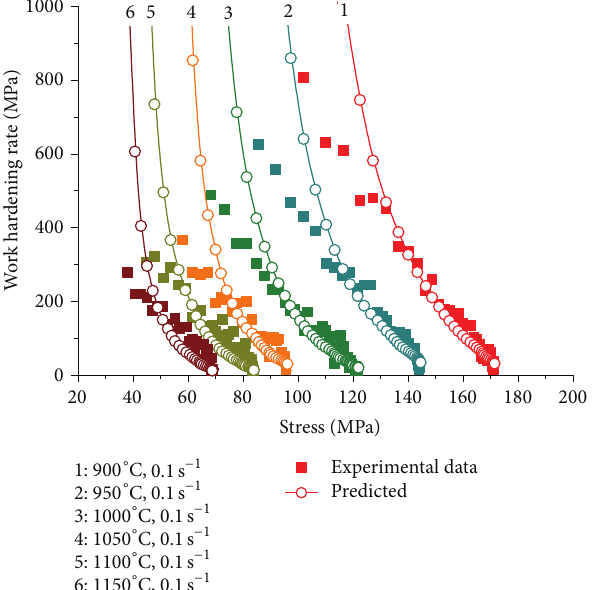
Figure 8: The plot of 𝜃 - 𝜎 for different deformation conditions.